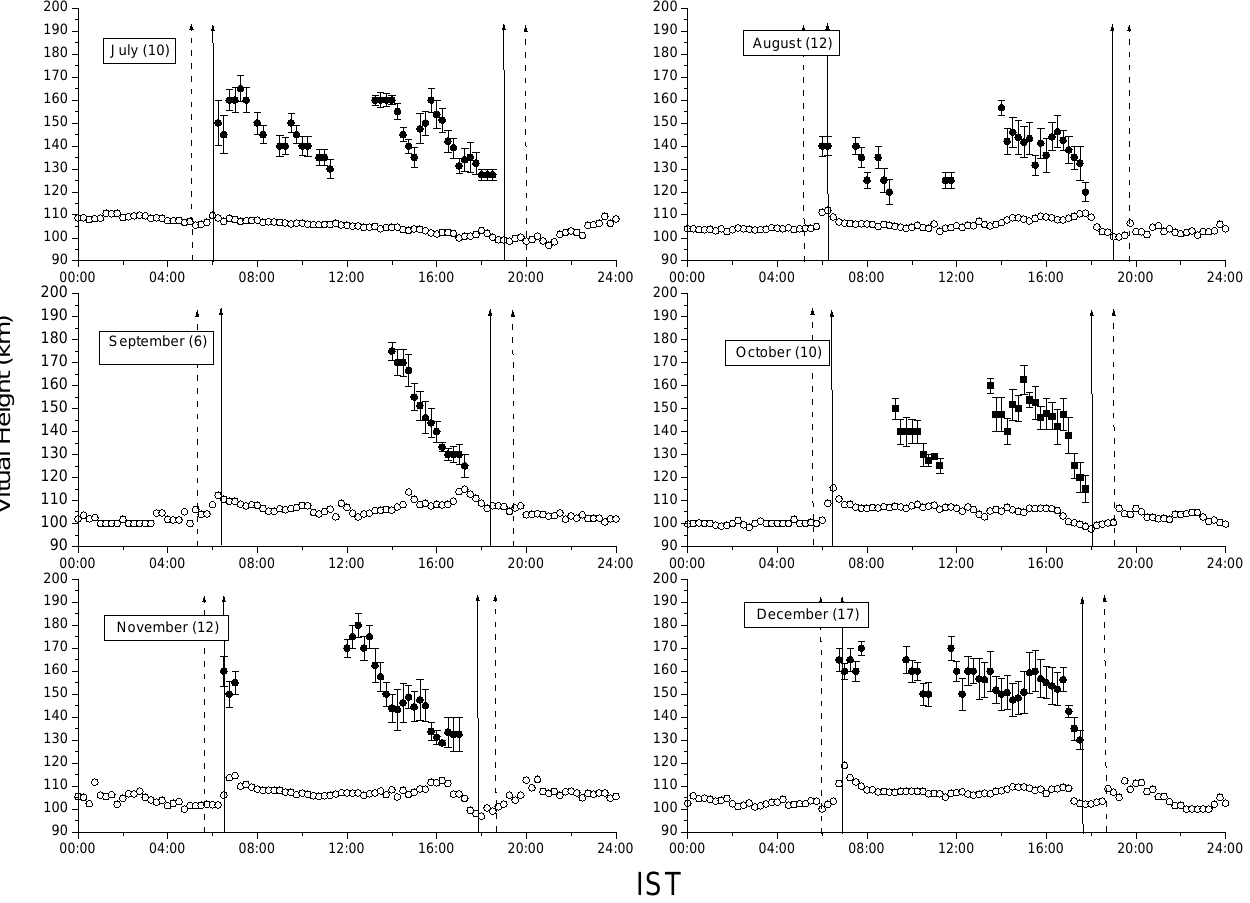
Fig. 4b. Monthly mean variation of virtual height of descending intermediate layer (solid dots) Es along with constant height Es (open circles) for July to December 2004 at a sub-tropical station Waltair. The error bars indicate the standard deviation of the mean. The vertical solid lines indicate the sunrise and sunset times at ground level and the dashed lines indicate those at an altitude of 150km.